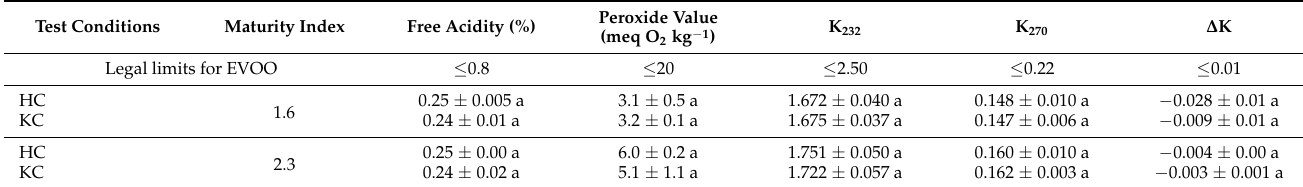
Table 5. Standard virgin olive oil parameters *.